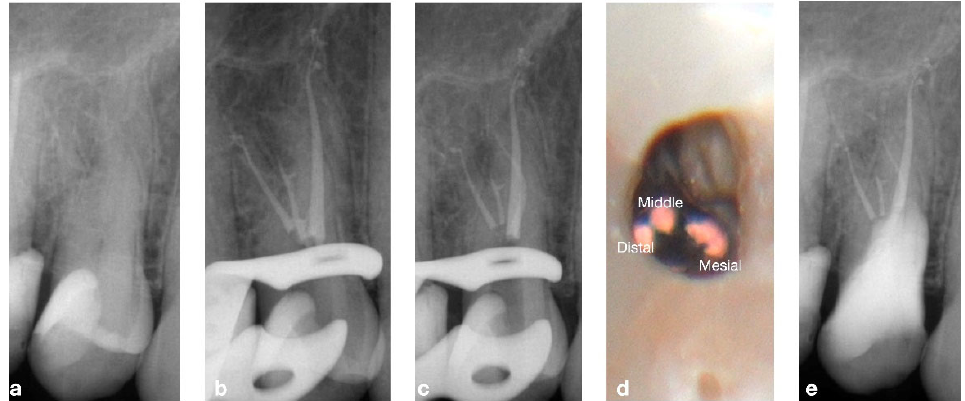
Figure 1. ( a ) Pre ‐ operative X ‐ ray showing the complex anatomy, ( b ) intra ‐ operative X ‐ ray after obturation of three canals, ( c ) intra ‐ operative X ‐ ray after obturation of the 4 th canal, ( d ) intra ‐ obturation of three canals, ( c ) intra-operative X-ray after obturation of the 4th canal, ( d ) intra-operative operative view of the three vestibular canals, ( e ) X ‐ ray of 6 ‐ month follow ‐ up. view of the three vestibular canals, ( e ) X-ray of 6-month